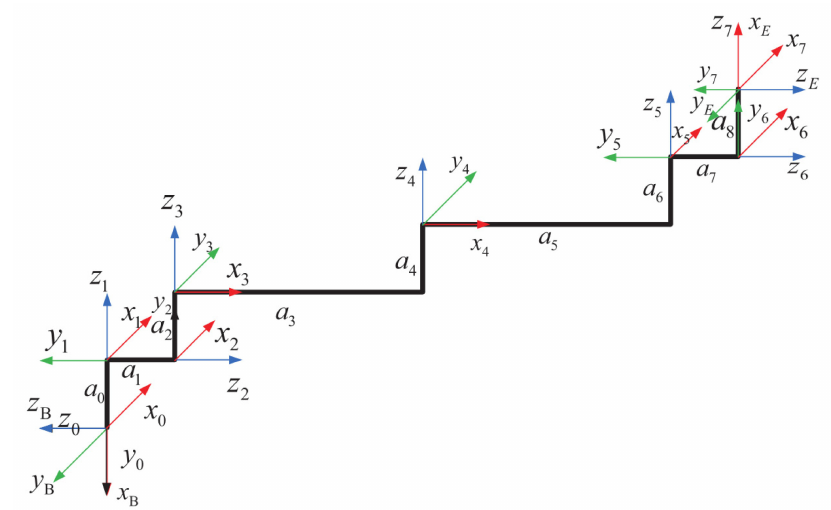
Figure 1. The coordinate system of the space manipulator.